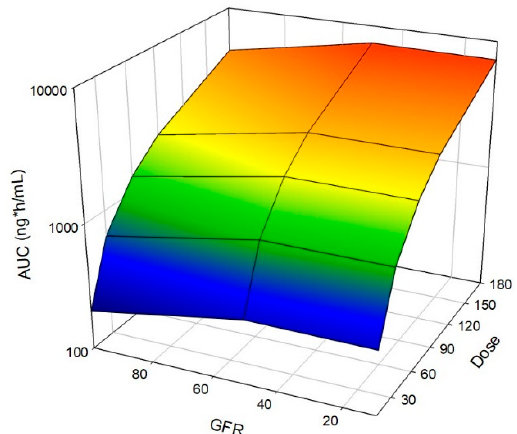
Figure 1. Impact of Renal Impairment on AUC of Nifedipine. Simulations with increasing oral doses (30 to 180 mg) were administered in a fasted state to an exclusively male population. Simulations included ten trials with ten individuals in each trial. Age ranged from 21 to 65 years, and simulations were conducted with varying the degrees of RI by utilizing the following populations, Sim-Healthy Volunteers, Sim-RenalGFR_30-60, and Sim-RenalGFR_less_30 to represent 100%, 50% and 10% GFR.